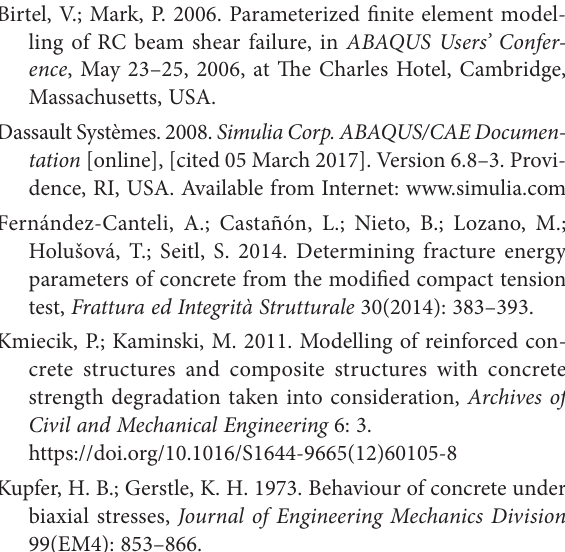
W ( J ) G ( J / m ) Error (%) f f 475.4 98.3 520